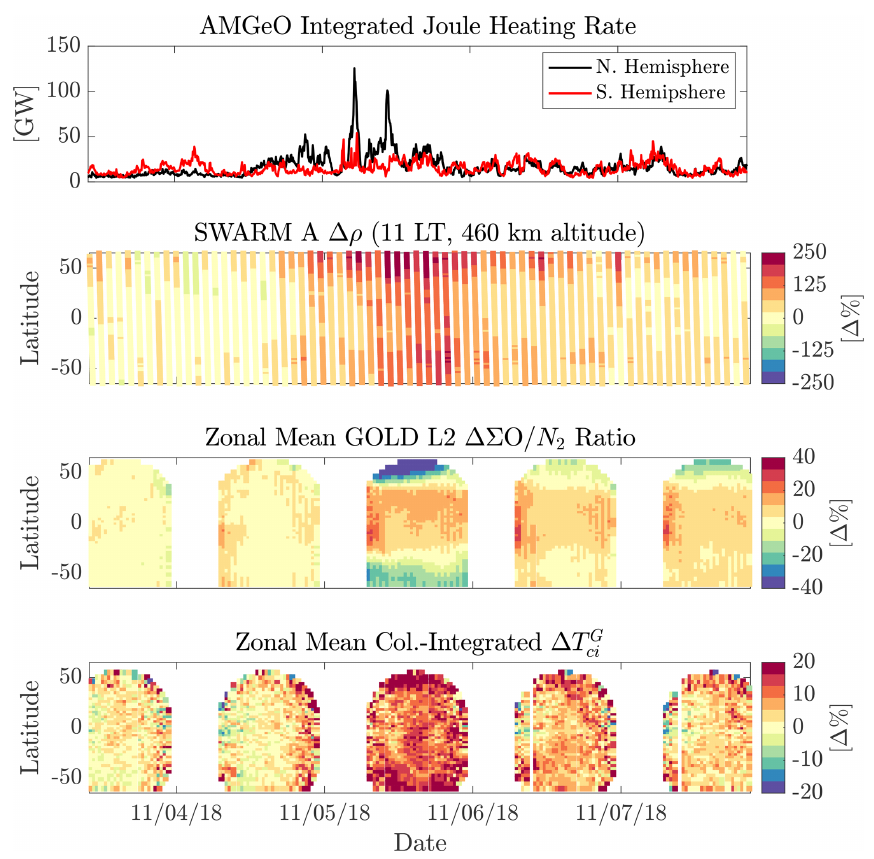
Figure 10. Storm-time response of the thermosphere as observed in three thermospheric variables as well as the hemispherically integrated Joule heating estimated using AMGeO. The percent change in mass density, ( (cid:49)ρ 460km ), column O / N 2 ratio ( (cid:49)(cid:54) O / N 2 ), and column- SWARM integrated temperature ( (cid:49)T G ) are computed with quiet-time conditions on 2 November ci